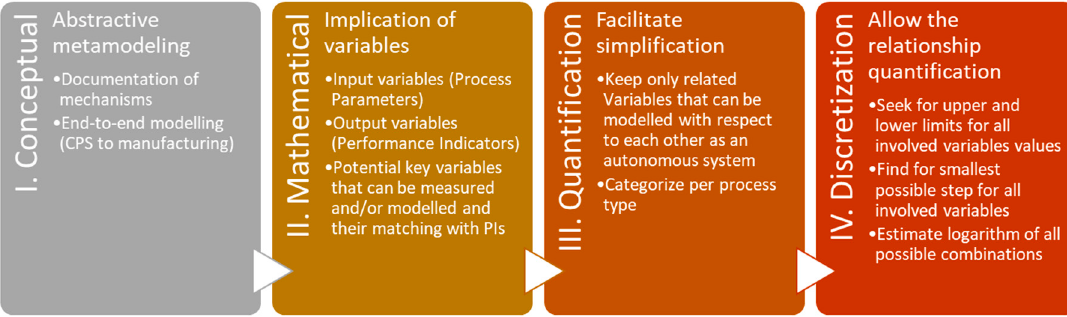
Figure 4. The current meta modelling framework.